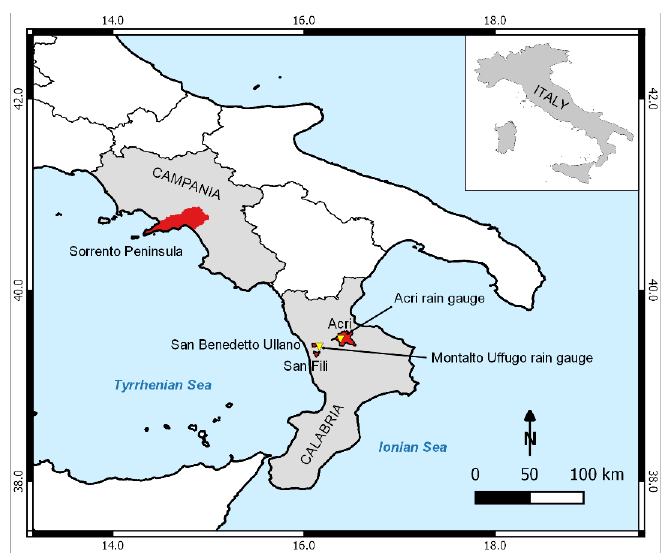
Figure 2. Location of the case studies (marked in red) in Calabria and Campania regions (marked in grey). Yellow triangles indicate Acri and Montalto Uffugo rain gauges.